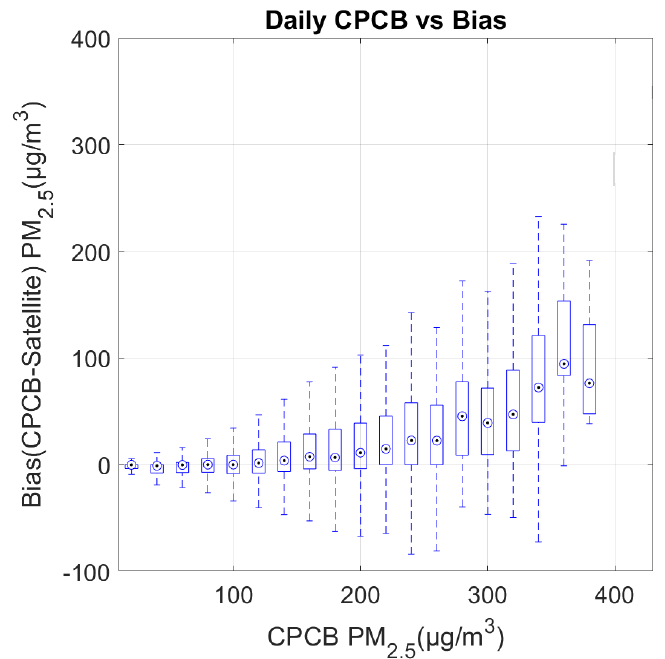
Figure 4. Variation in the bias in daily satellite-based PM 2.5 concentrations relative to the ground- measurements with an increase in the PM 2.5 level. The box plots represent 5–95 percentile based measurements with an increase in the PM 2.5 level. The box plots represent 5-95 th percentile levels.